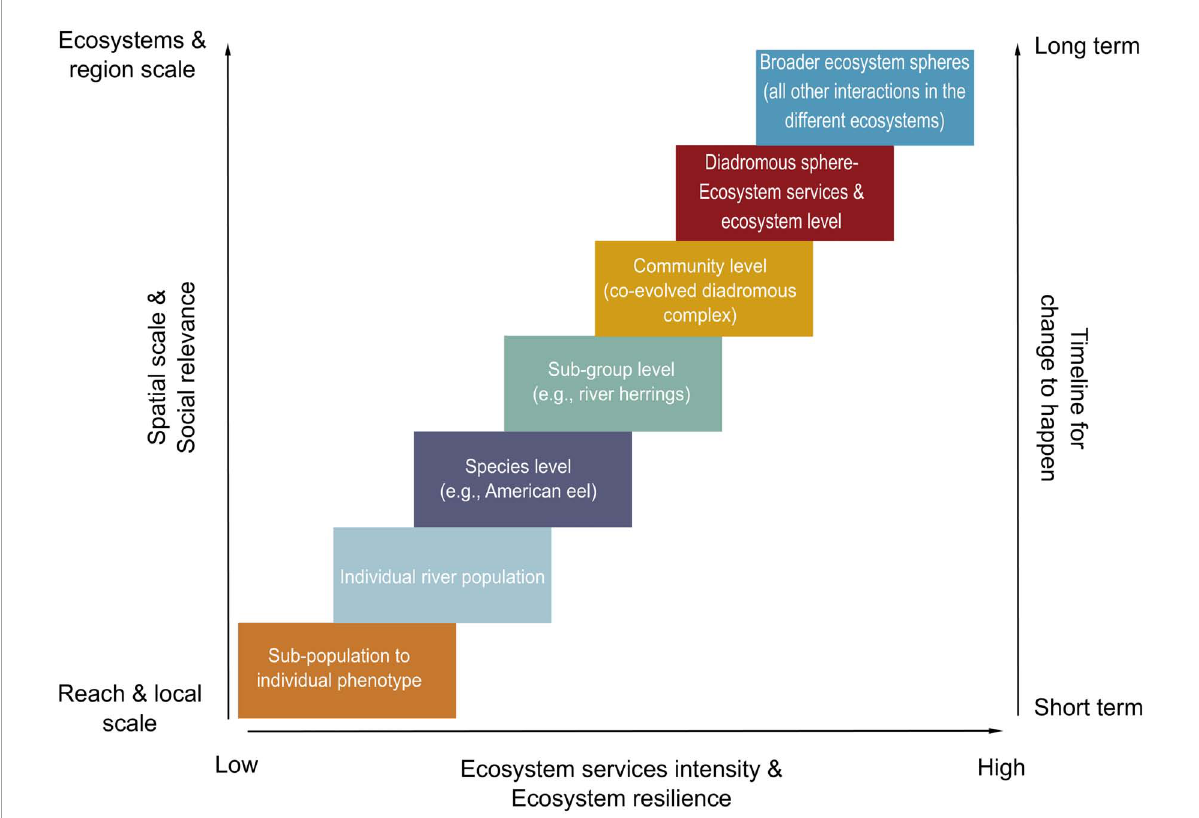
FIGURE6 Conceptual model using the portfolio effect concept applied to the management of the diadromous species in relation to the scale of actions, social relevance, ecosystems’ resilience, ecosystem services intensity, and timeline for change. The figure is conceptual in nature, meaning that the various axes should not be quantitatively interpreted. The joint topics on the axes do not mean that they are explicitly linked, rather than operating on their own relative spatio-temporal scales. The diadromous sphere box refers to the diadromous community and essential freshwater habitat coupled with ALL the species they interact with (i.e., primary producers to predators), while the broader ecosystem sphere refers to all the other interactions, e.g., freshwater and marine harvest, marine predators, terrestrial insects, avian predators,